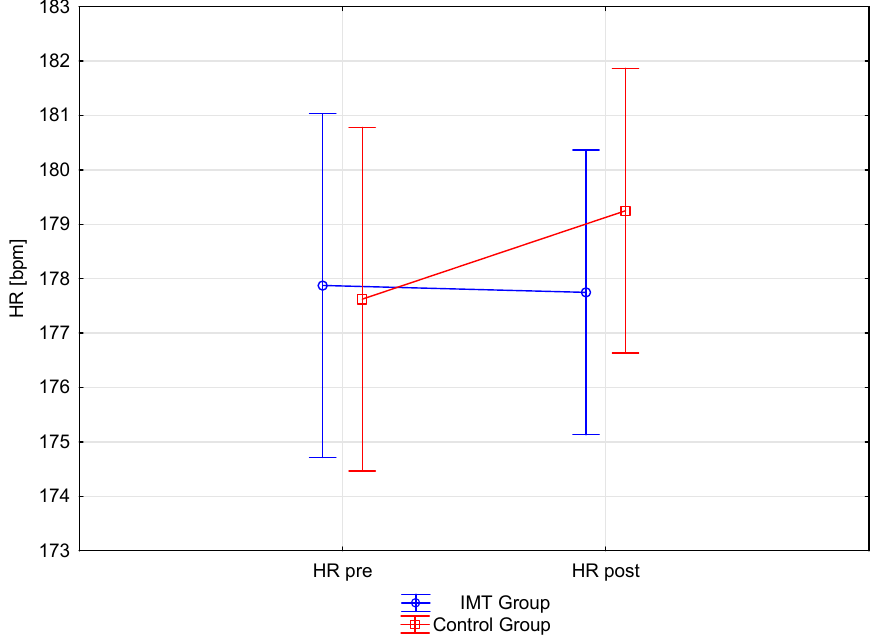
Figure 1. Mean heart rate (HR) measurement pre- and post-inspiratory muscle training (IMT) and endurance training. Vertical bars represent the confidence interval of 0.95.